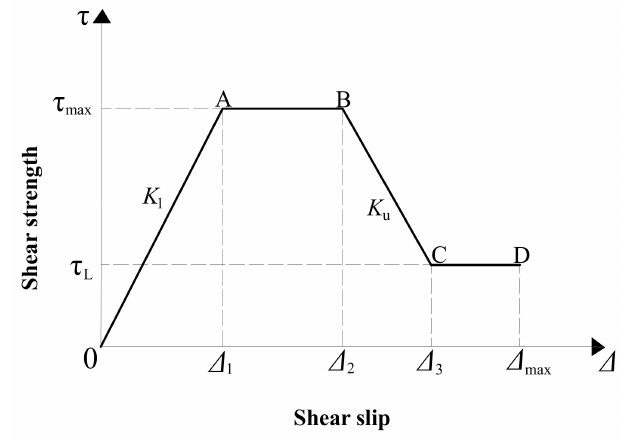
Figure 3. Shear resistance